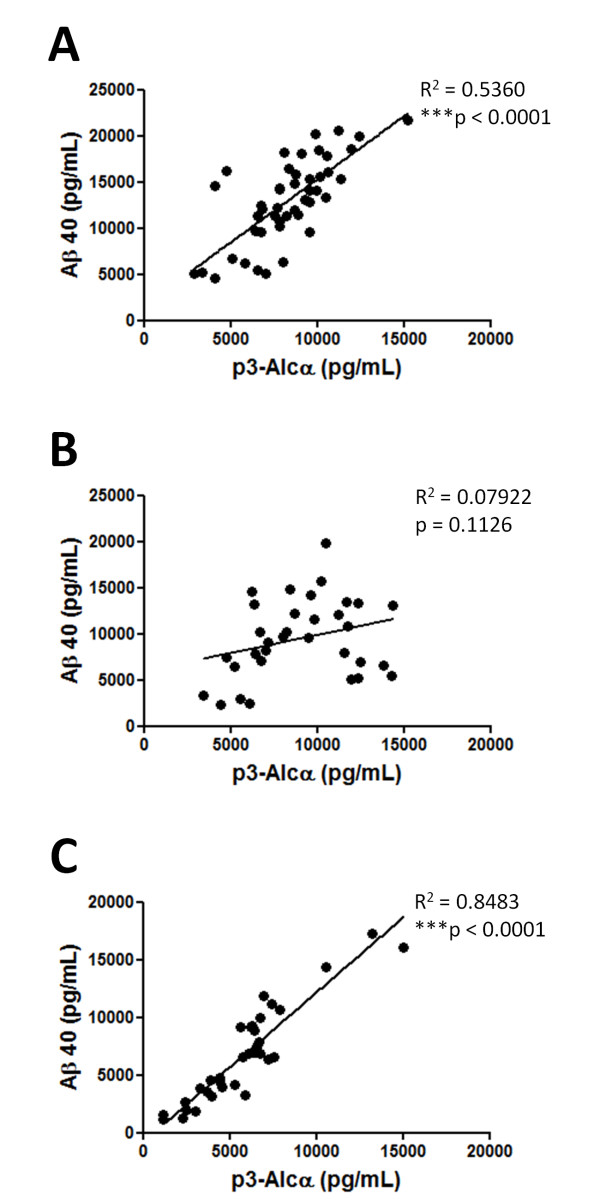
Correlation of p3-Alcαlevels with Aβ40 level in subjects with CDR 0.5, 1 and 2–3. Correlation of CSF p3-Alcα and Aβ40 levels was explored in subjects with CDR 0.5, 1 and 2 in cohort 1 (A, n = 46), in subjects with CDR 0.5 and 1 in cohort 2 (B, n = 33), and CDR 0.5, 1 and 2–3 in cohort 3 (C, n = 34). The relation between p3-Alcα and levels was investigated by Pearson's correlation coefficient test (GraphPad Prism 5). Statistical significance is indicated in figure with asterisks.